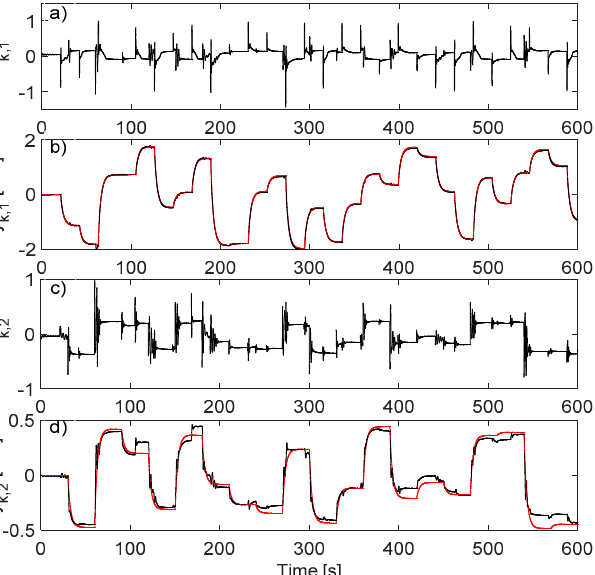
(red); ( c ) u k,2 ; ( d ) y k ,2 (black), y m k ,1